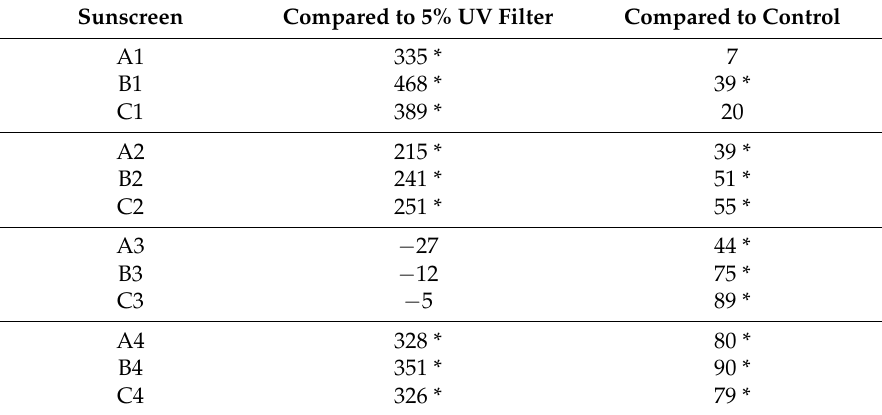
Table 3. Percent boost of in vitro sun protection factor (SPF) compared to the individual ultraviolet (UV) filter and the control